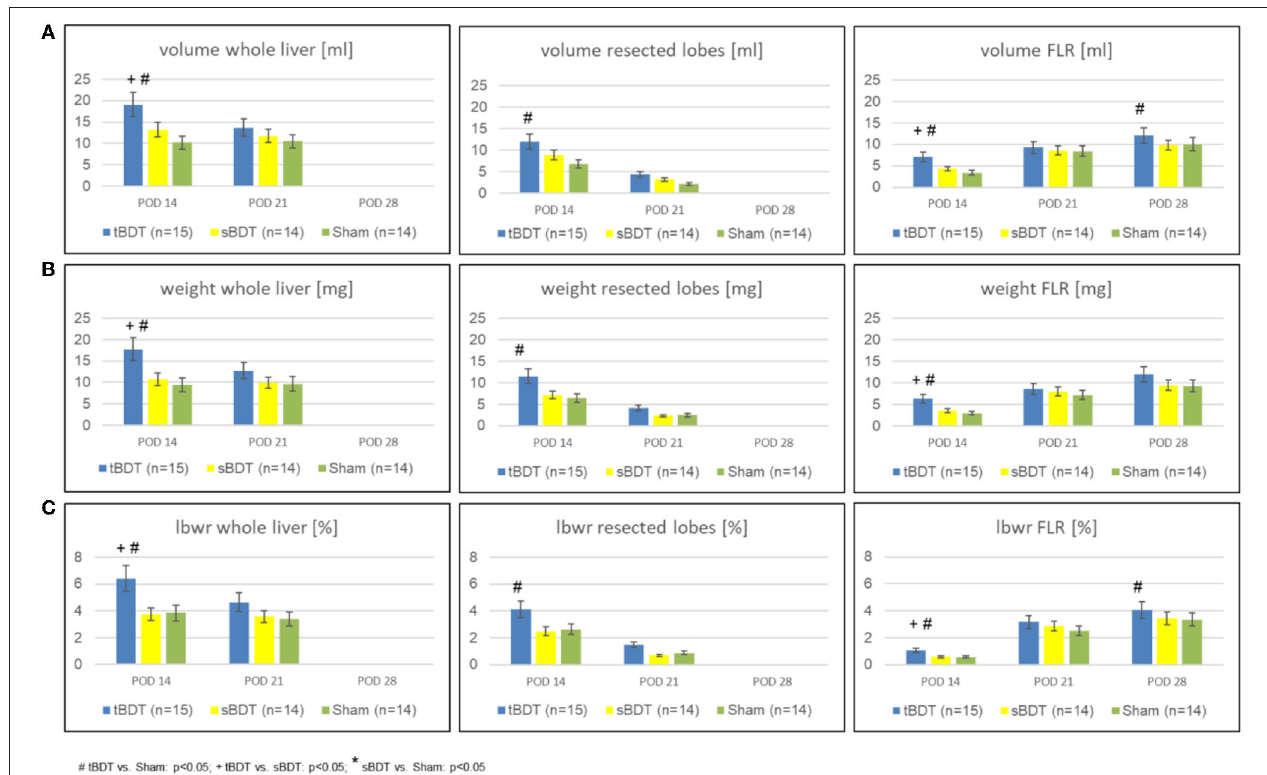
FIGURE 2 | Variation of (A) volume, (B) weight, and (C) lbw-ratio of whole liver, resected lobes and FLR during the sequence “repeated regeneration stimuli” in different extents of biliary occlusion (tBDT 100%, sBDT 70%, Sham 0%) in rats ( n = 45). We show the data for “whole liver”, the “future resected lobes” and for FLR of every group at the three time points of the sequence to illustrate the dynamic alterations of liver regeneration (# tBDT vs. Sham: p < 0.05; + tBDT vs. sBDT: p < 0.05; * sBDT vs. Sham: p <